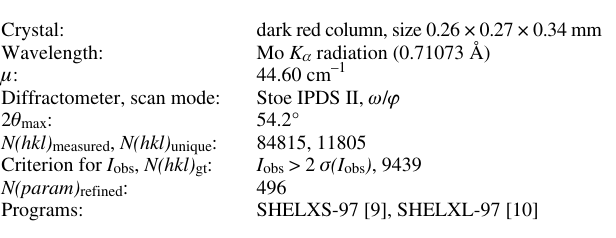
Table 1. Data collection and